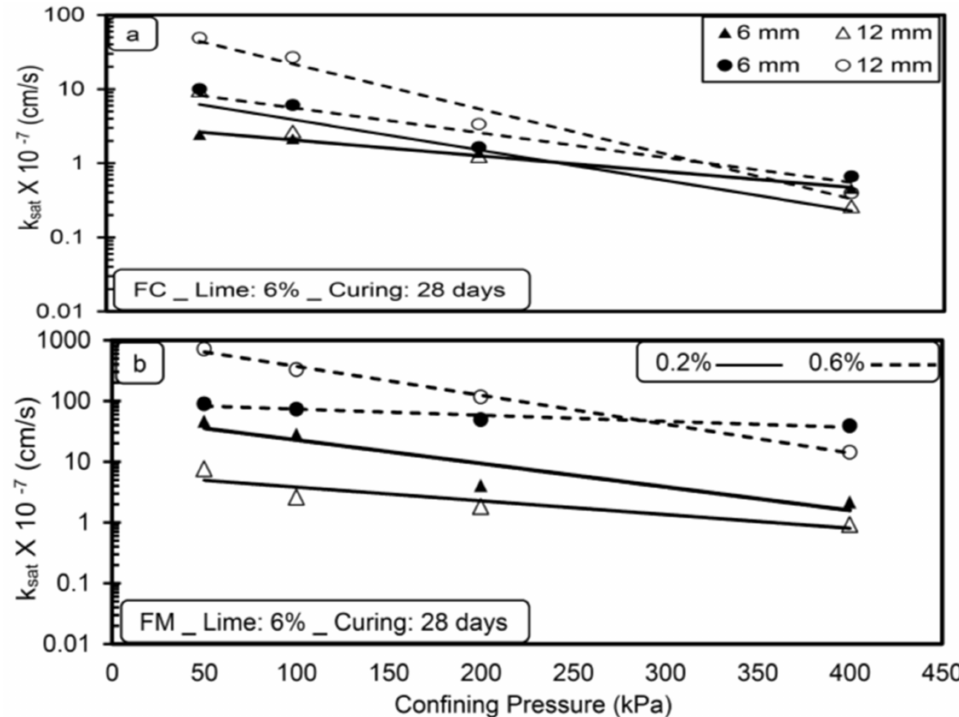
Figure 6. Variation of saturated hydraulic conductivity with confining pressure ( a ) FC ( b ) FM with lime treatment (after 28-day curing